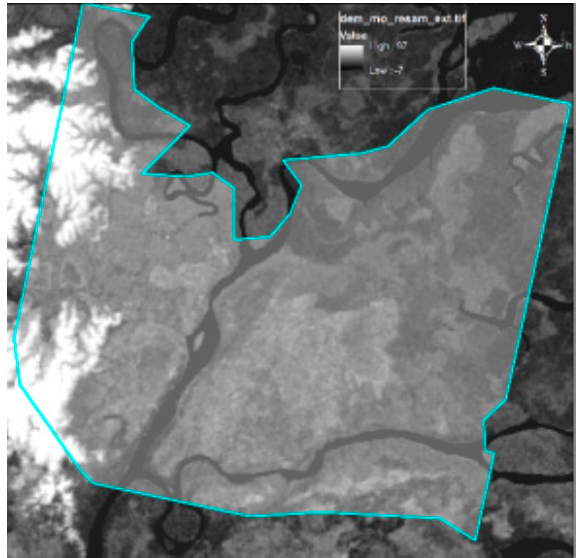
Figure 4. IM0104 Geo-eco zone digital evaluation model (DEM).